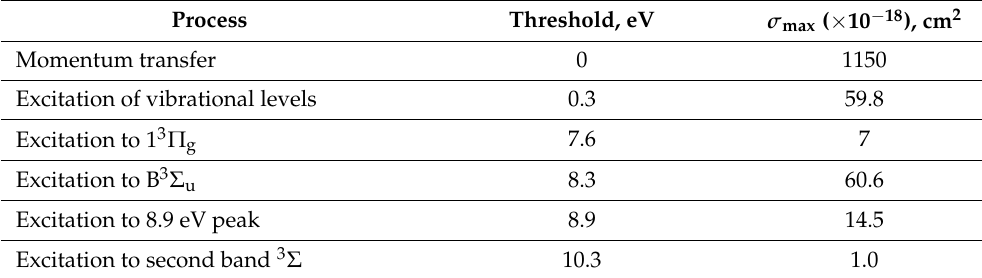
Table A2. Electron impact on O 2